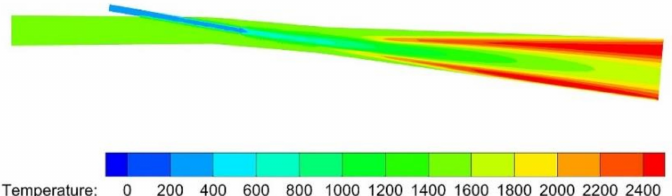
Figure 5. Temperature distribution in the blowpipe-tuyere-combustion zone.